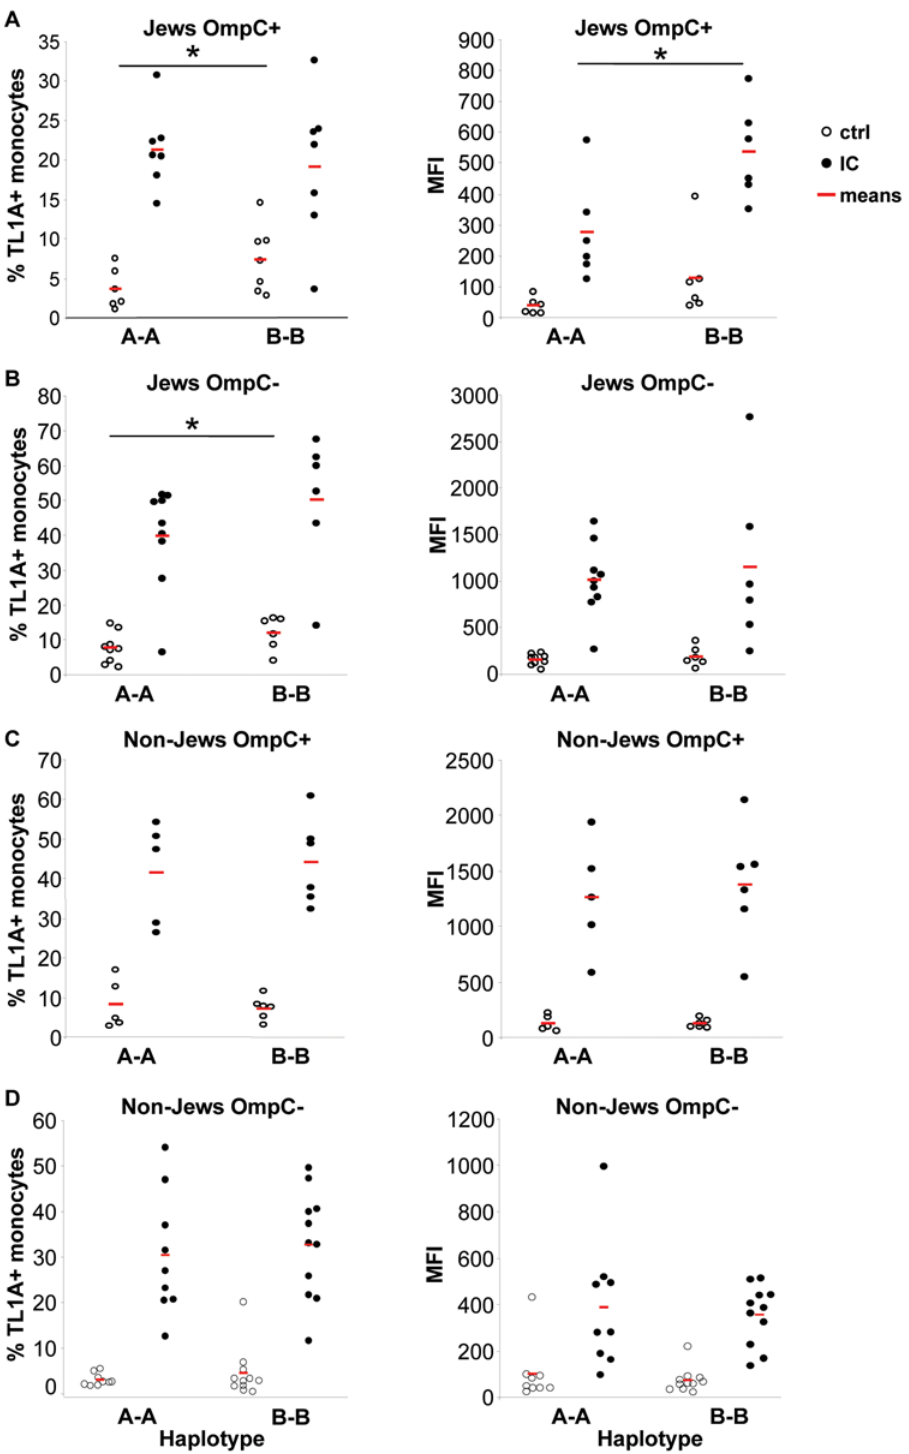
Figure 5. The B risk haplotype is associated with an increase in the number of TL1A + peripheral monocytes in Jewish but not in non-Jewish CD patients. ( A ) Monocytes from Jewish OmpC + patients with A or B haplotypes were stimulated with IC for 16 h. Monocytes were stained with an anti-TL1A antibody and analyzed by flow cytometry. Data are presented as % of TL1A + monocytes (left panel) or mean fluorescence intensity (MFI) (right panel) (n=6, or 7 for haplotype A or haplotype B , respectively, *, P # 0.05 for % TL1A + ; *, P # 0.02 for MFI). ( B ) Monocytes from Jewish OmpC 2 patients with A or B haplotypes were stimulated with IC for 16 h. Data are presented as % of TL1A + monocytes (left panel) or MFI (right panel). (n=9 or 6 for haplotype A or haplotype B , respectively, *, P # 0.05) ( C ) Monocytes from non-Jewish OmpC + patients with A or B haplotypes were stimulated with IC for 16 h. Data are presented as % of TL1A + monocytes (left panel) or MFI (right panel). (n=5 or 6 for haplotype A or haplotype B , respectively). ( D ) Monocytes from non-Jewish OmpC 2 patients with A or B haplotypes were stimulated with IC for 16 h. Data are presented as % of TL1A + monocytes (left panel) or MFI (right panel). (n=9 or 11 for haplotype A or haplotype B , respectively).